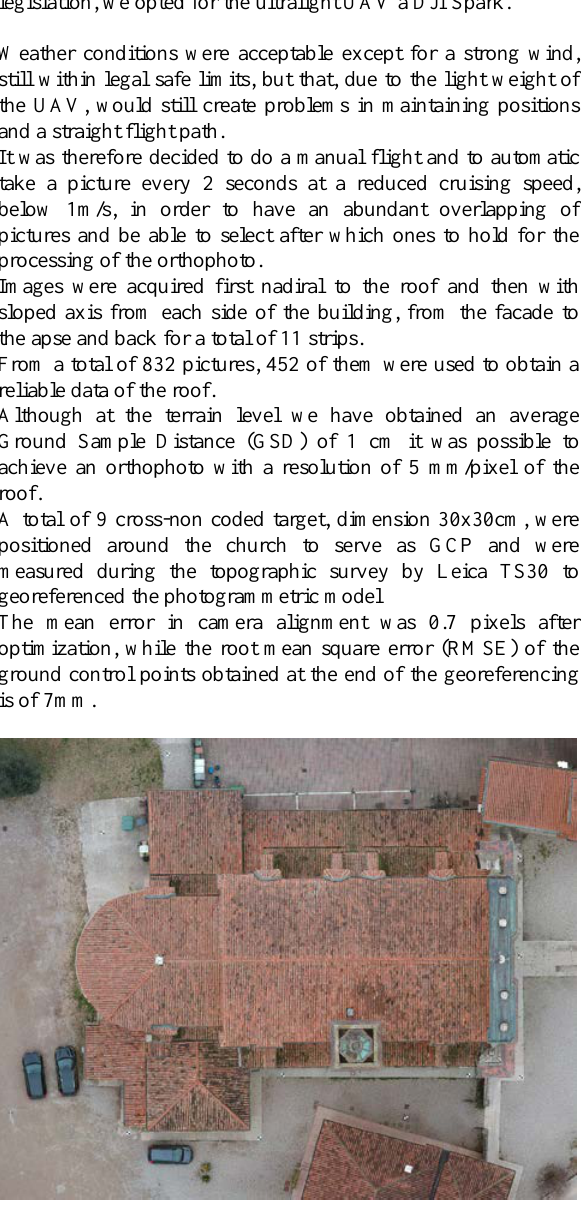
Figure 7. Orthophoto of the roof the Church in Roverbella at the scale 1:50, with a GSD (on the roof) of 5